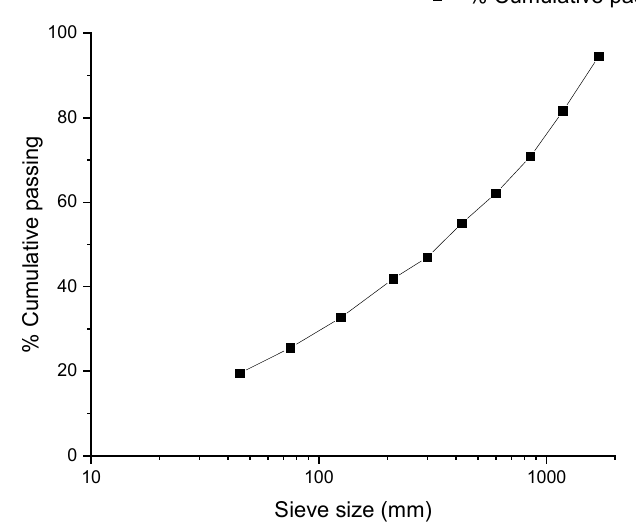
Figure 1. Particle size distribution of the silicate-based ore. Scanning electron microscopy (SEM) was used to study the sample’s surface mor- phology, as presented in Figure 2. The EDS spectrum shows the distribution of the chemical elements. As shown, the sample matrix is mainly composed of silicon and oxygen, indicating the presence of silicates as the main compounds. Calcium and iron were also identified. Among the minor elements presented in Table 3, zirconium, lan- thanum, cerium, neodymium, and yttrium were identified. These results are in line with the chemical